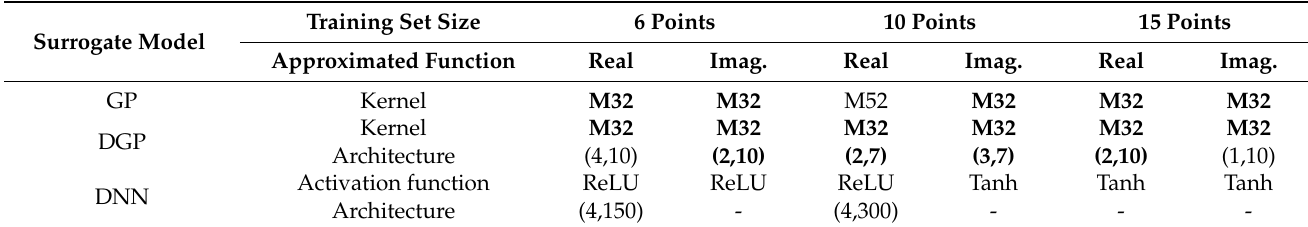
Table 10. Best hyperparameter setting of GP, DGP and